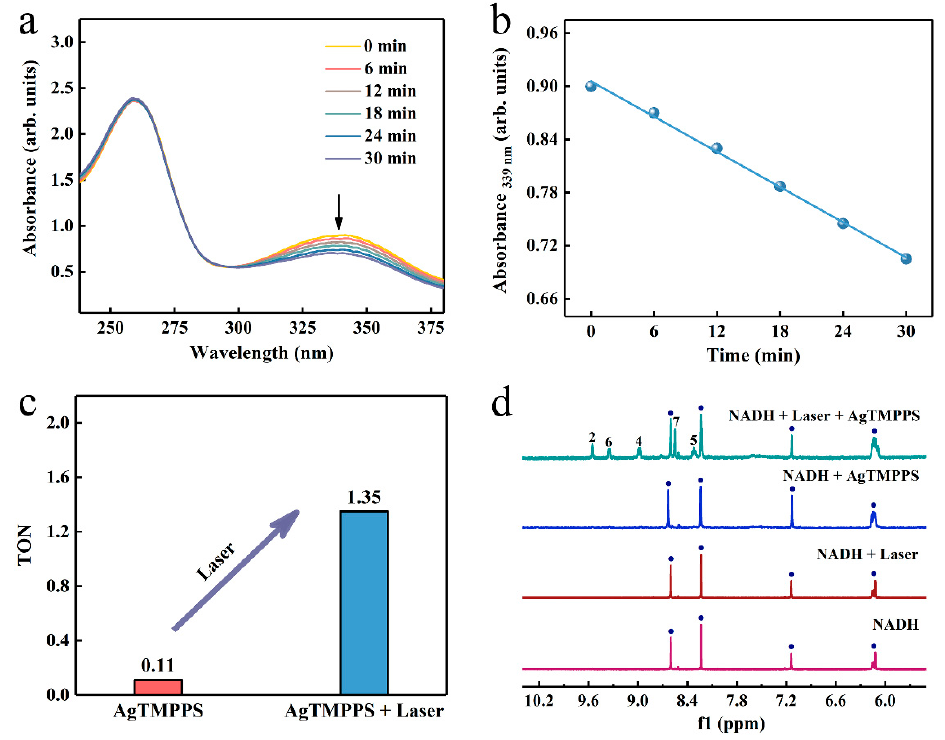
Figure 6. Photocatalytic oxidation of NADH by AgTMPPS and laser irradiation (460 nm, 0.05 W/cm 2 ). ( a ) Reaction of AgTMPPS and NADH in ultrapure water under laser irradiation detected by UV-vis spectra. ( b ) Rate constant for NADH depletion as a function of the laser irradiation time in the presence of AgTMPPS. ( c ) TONs of NADH oxidation for the AgTMPPS and AgTMPPS + Laser groups. ( d ) Photocatalytic oxidation of NADH by AgTMPPS monitored by 1 H NMR spectroscopy. The numbers denote the proton positions of NAD + nicotinamide (Figure S10). The blue circles represent the signal peaks of NADH.